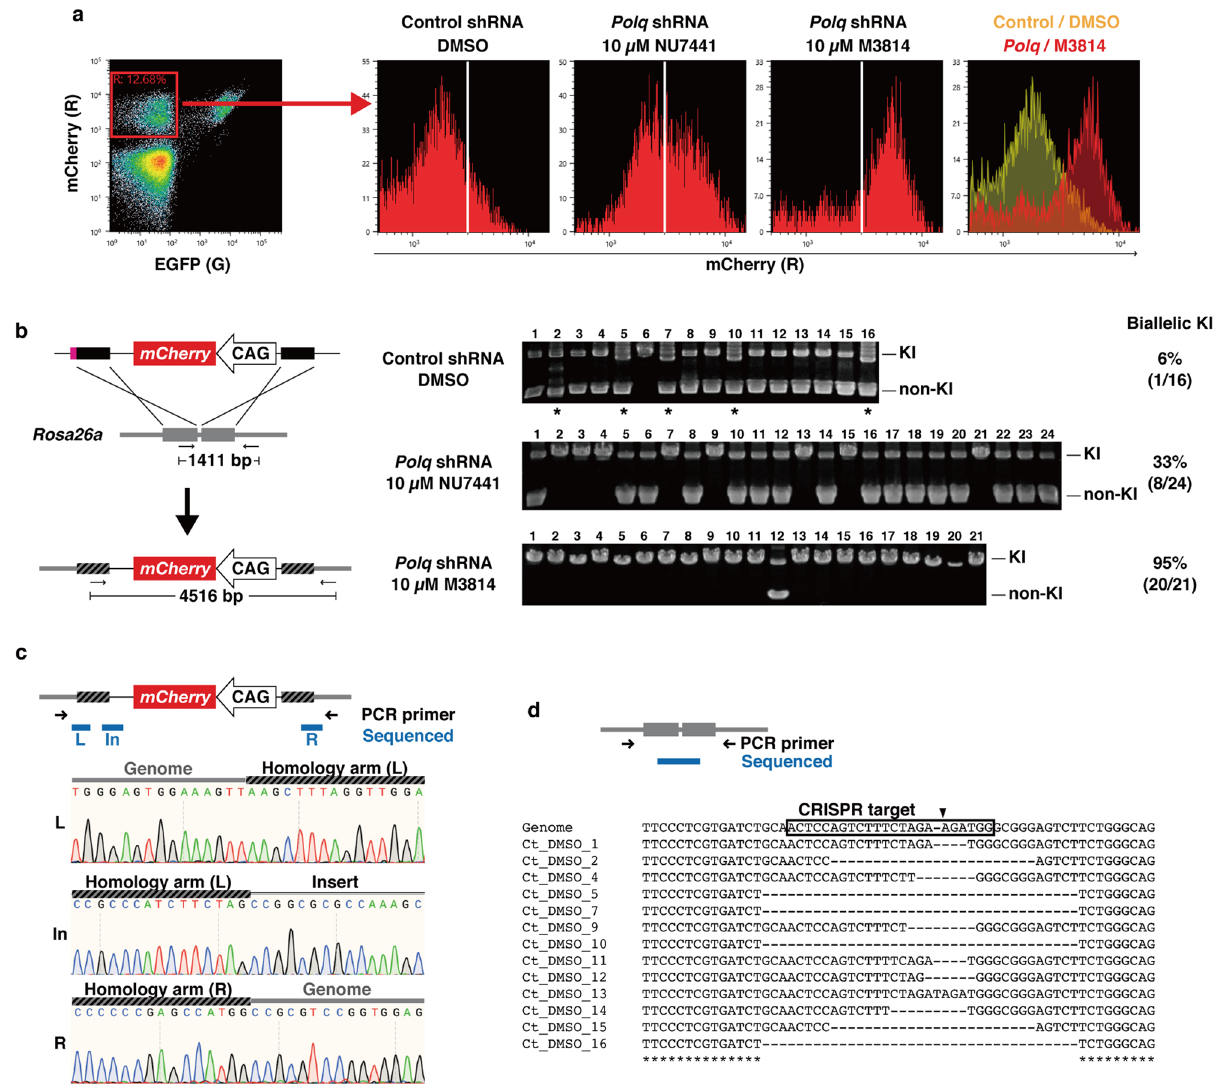
Figure 3. Biallelic knock-in of mCherry into Rosa26a promoted by Polq knockdown and DNA-PK inhibition. ( a ) Fluorescence intensities of mCherry in R+G− populations from the experiments shown in Fig. 2c,d. Representative histograms from three experiments are shown. ( b ) Genomic PCR analysis of clones isolated from R+G− populations. Left, position of primers and the size of amplicons are shown. Right, the PCR products were analyzed on agarose gels. Positions of knock-in allele (KI) and non-knock-in allele (non-KI) are indicated. Asterisks indicate clones in which PCR bands of unexpected size were observed. The three groups were analyzed on different gels. The full-length gels are shown in Fig. S3. ( c ) Sequence analysis of the knock-in allele. Top: The position of amplification primers and sequenced regions are shown. Bottom: Sanger sequence traces at the left junction (L), the junction between the left arm and the foreign sequence (In), and the right junction (R). Representative data from Polq shRNA + 10 µM M3814 clone 1 are displayed. Sequences of other clones are shown in Fig. S4. ( d ) Sequences of the non-knock-in alleles of control cell clones (control shRNA + DMSO). The predicted cut site (− 3 bp from the protospacer adjacent motif) is shown by the